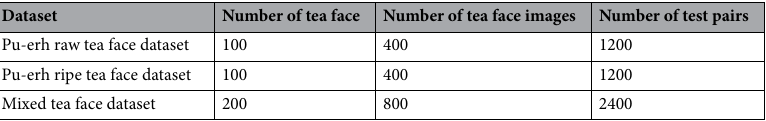
Table 2. Test dataset